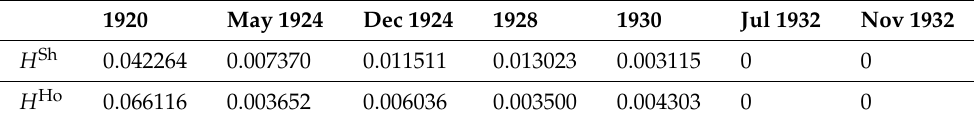
Table 1. Results for the Weimar Republic parliament in 1918–1932.